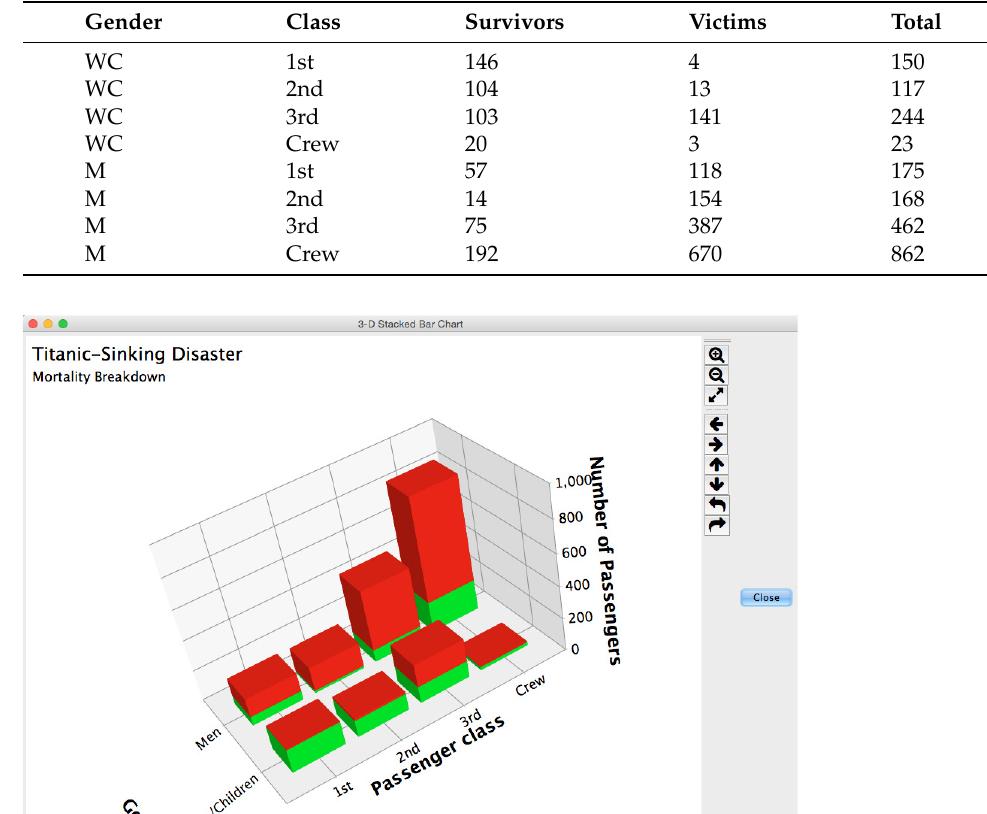
Table 1. Data used by Thoth to make Figure 1, from Table 1 of Hall [3]. In the gender column, WC = Women/Children and M = Men.